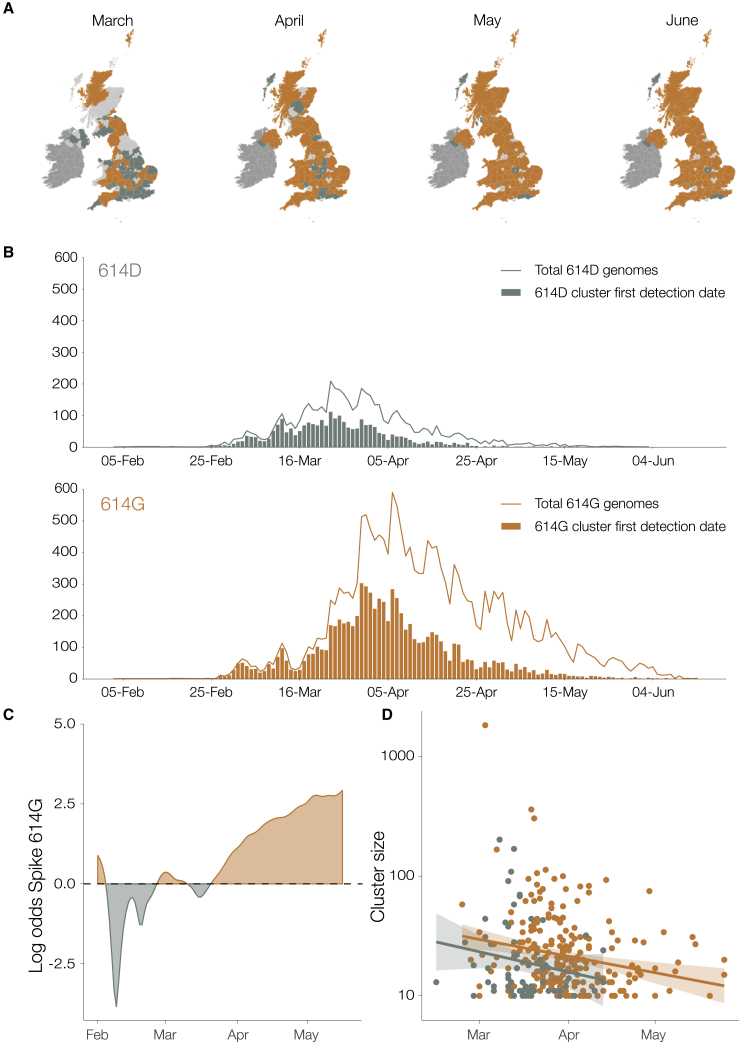
Geographic and Temporal Distribution of UK Phylogenetic Clusters, Classified as 614D or 614G According to the Residue They Carry at Spike Protein Position 614D(A) Shaded regions show the predominant residue in each region on the 15th of each month for March, April, May, and June 2020, with orange indicating that 614G was more frequently sampled and green indicating that 614D was more (or equally) frequent. Light gray indicates that no sequences had been sampled by that point in time. Dark gray indicates the Republic of Ireland.(B) The date when each cluster was first detected in the United Kingdom for variants 614D and 614G. Each cluster contains two or more sampled genomes. Solid lines show the total number of sequences collected by day of each 614 variant.(C) The log odds of sampling a 614G variant over time.(D) The size of cluster versus time of first sample collected within a cluster.